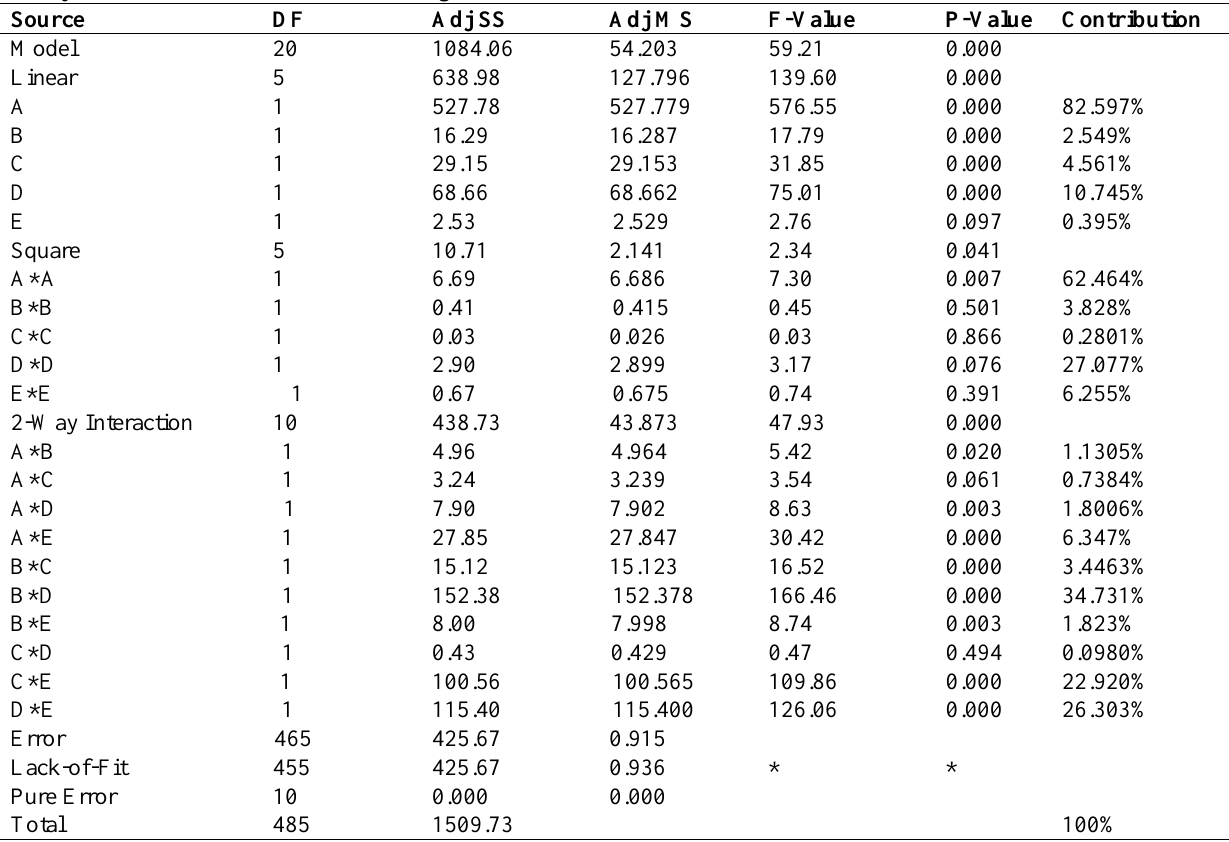
Fig. 8. Interaction plot of parameters . Table 5, Analysis of variance results of convex region in free form